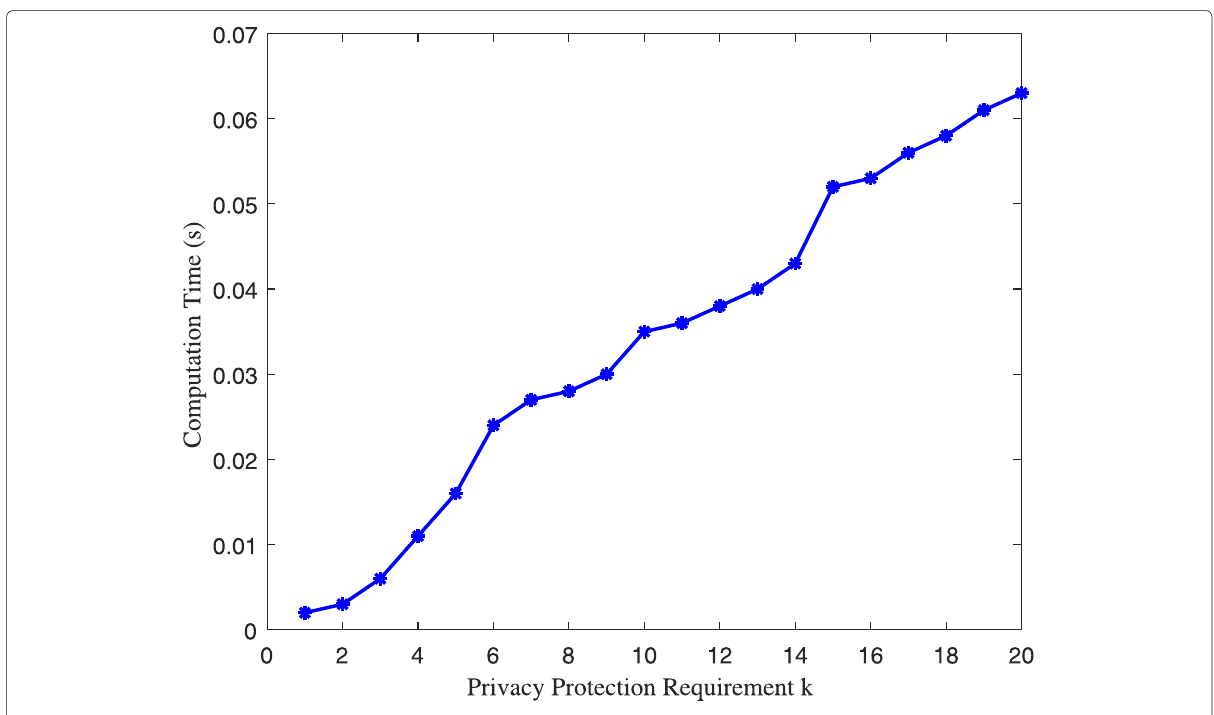
Fig. 11 The computation time of constructing the anonymous cloaking fore, we will establish a game model by balancing the demand for privacy protection and the quality of service (computational time overhead) to optimize the value of k in our future